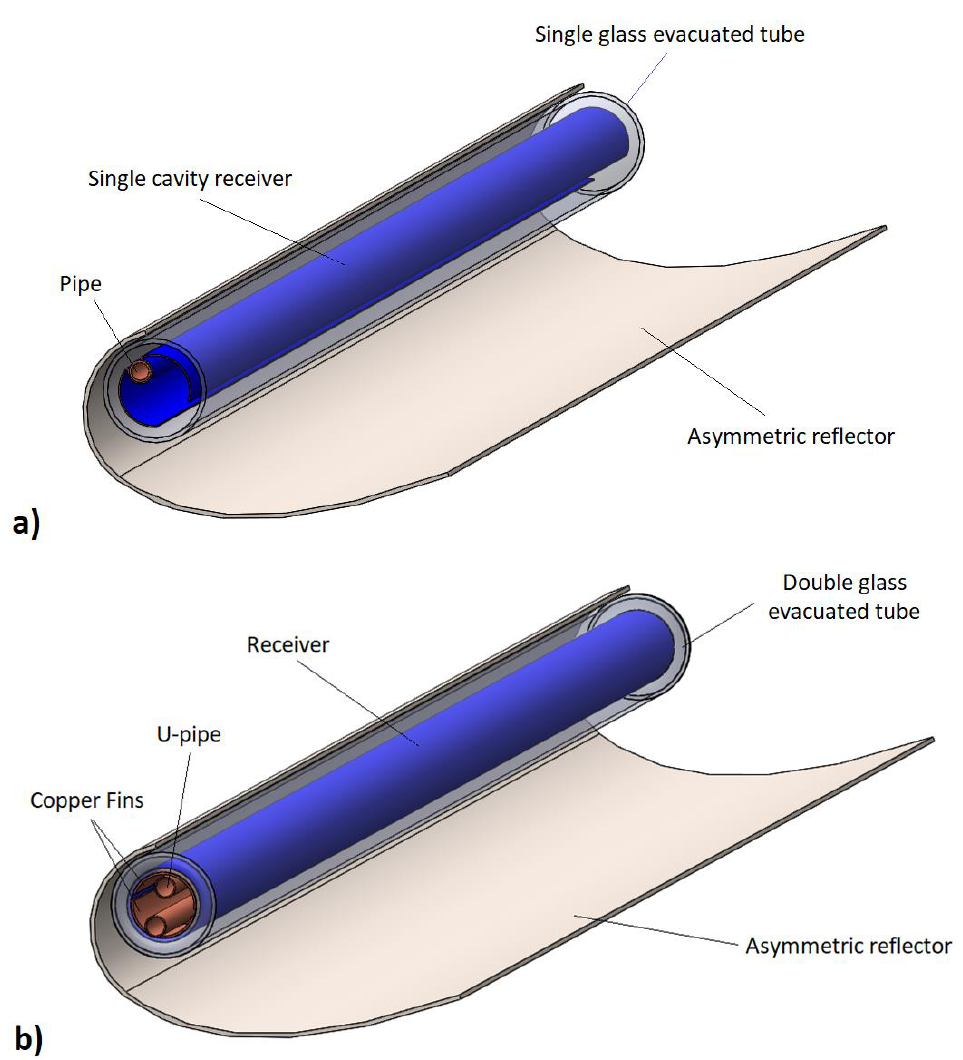
Figure 1. Design of the examined CPCs: ( a ) SC-ACPC (novel design) and ( b ) CNV-ACPC ([25]). Reprinted with permission from Ref. [25]. 2022, Elsevier. Table 1. Dimensions of the examined CPCs.